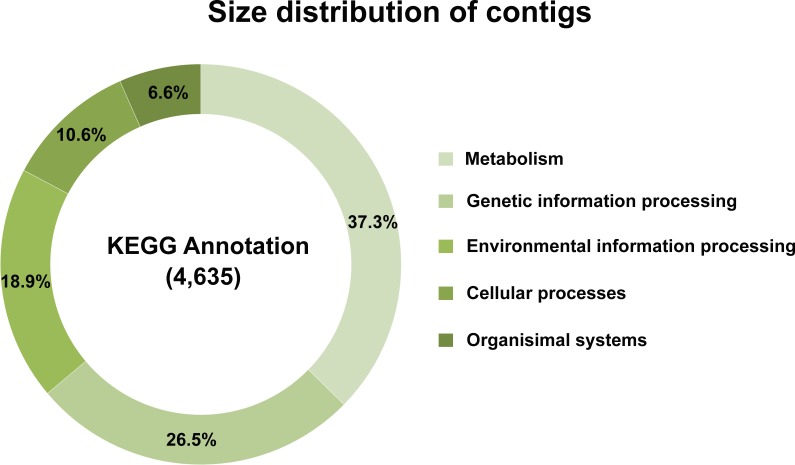
Overview of KEGG annotation.A total of 4,653 genes were grouped into five functional categories with the majority in the metabolism category.